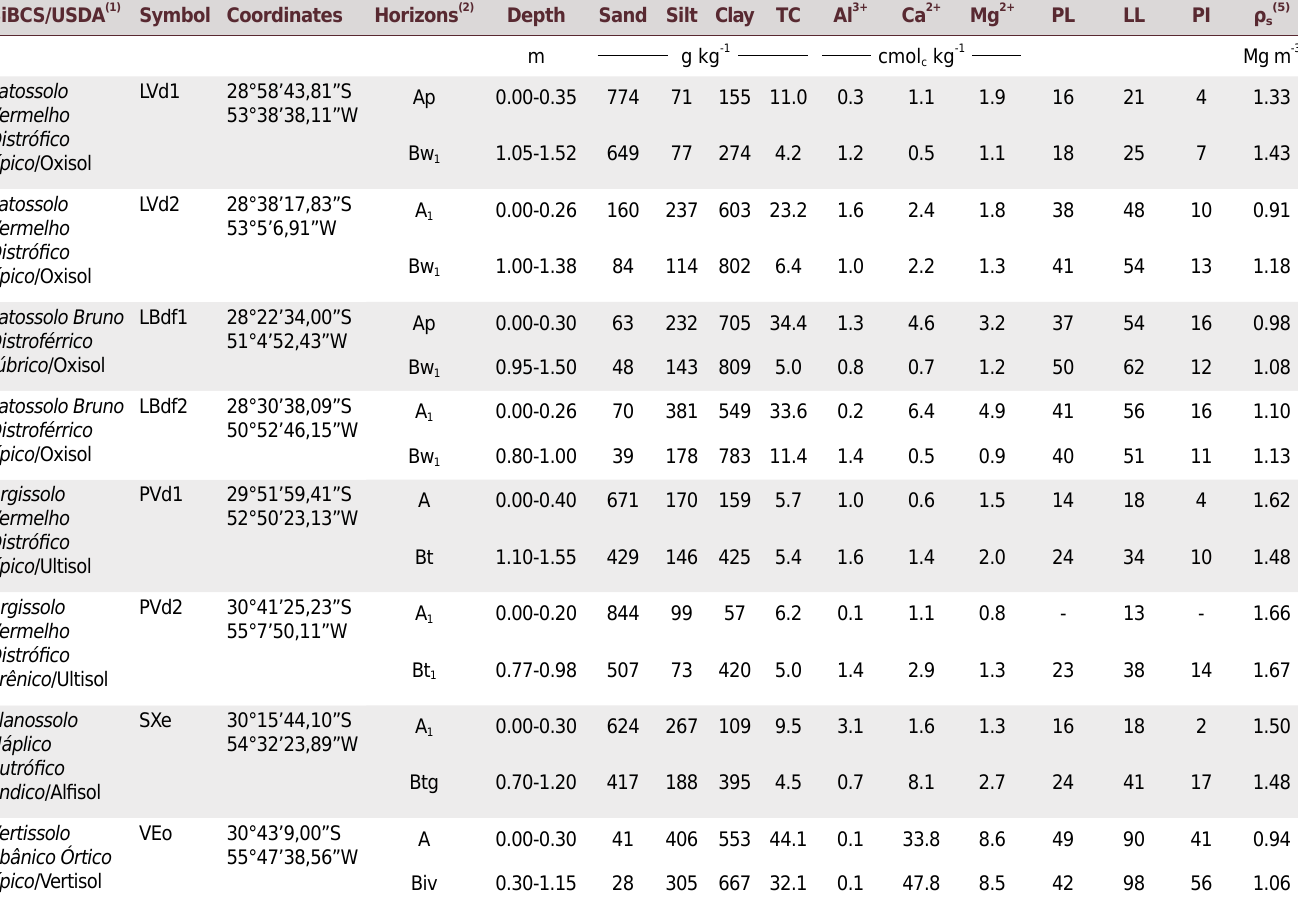
Table 1. Classification, symbol, coordinates, horizons, depth, and physical and chemical characterization of eight studied soils SiBCS/USDA (1) Symbol Coordinates Horizons (2) Depth Sand Silt Clay